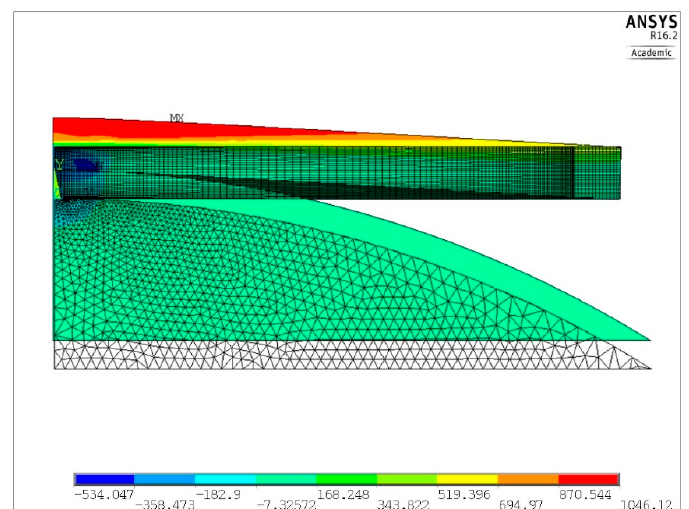
Figure 8. Distribution of the first principal stress S 1 produced by the second loading semi-cycle, for Δ U 3 = 334.2 μ m.